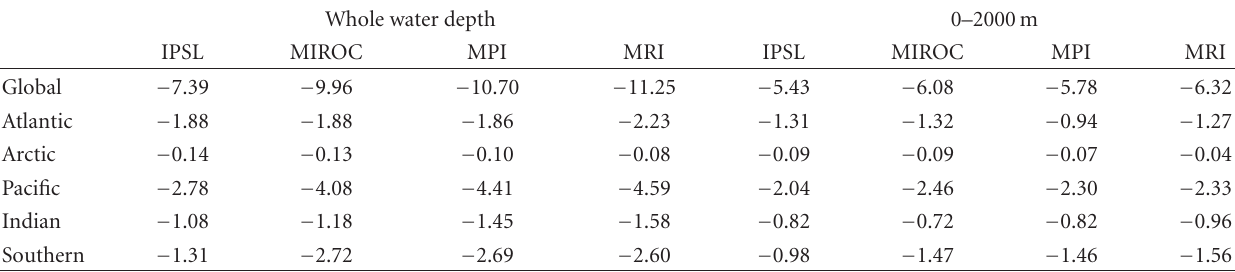
Table 2: Ocean heat content change ( × 10 24